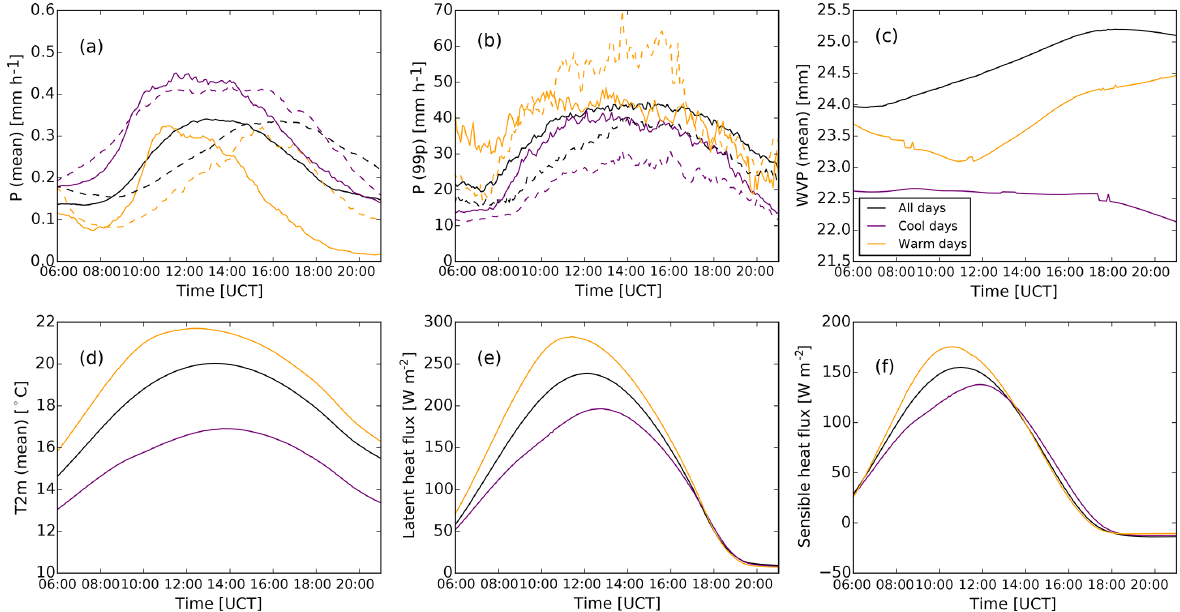
Figure 8. Diurnal cycles of mean precipitation intensity (a) , 99th percentile of precipitation intensity (b) , water vapor path (c) , air temperature at 2m (d) , surface latent heat flux (e) , and surface sensible heat flux (f) , for all days, cold days, and warm days of the 36d simulation with 625m grid spacing. In panels (a) and (b) , solid lines show simulation data, and dashed lines show RADOLAN data. Averaging was carried out over all grid boxes where radar data are